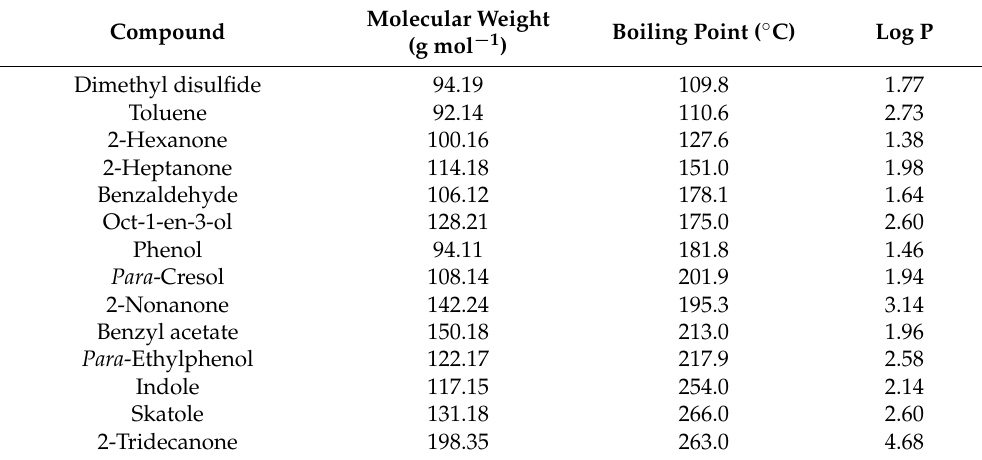
Table 1. Selected physical properties of compounds quantified in this study (listed in elution order on a DB-5 gas chromatography column. 1 )